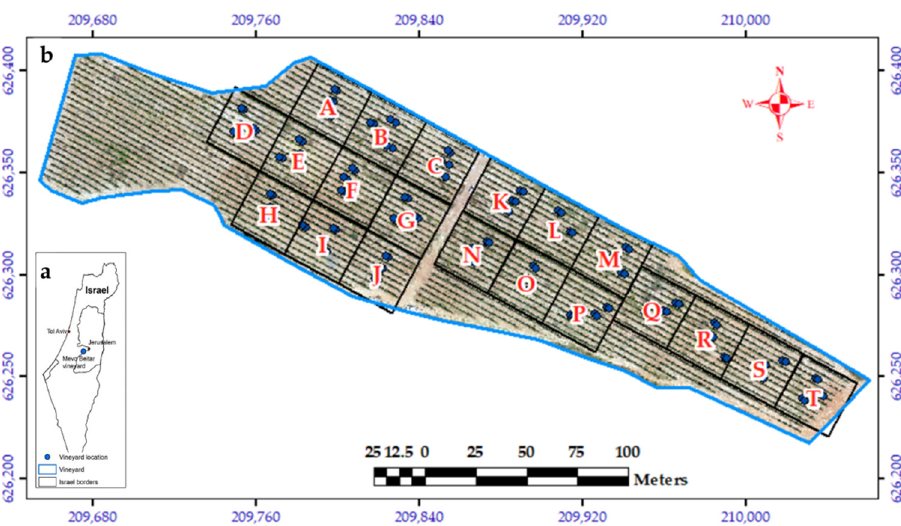
Figure 1. The study site: ( a ) vineyard location within Israel; and ( b ) Mevo-Beitar experimental vineyard. Management cells are represented in black squares with different English alphabet letters ( n = 20). Measurement vines are marked as blue dots ( n = 120), and yield-monitored vines ( n = 240) as blank open circles.